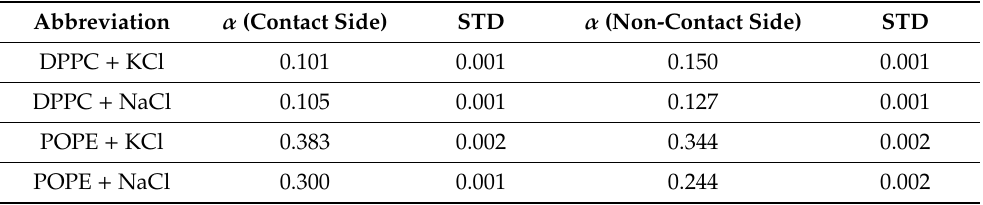
Table 1. α parameters based on the fitting function presented in Equation (2). All results were obtained for the bilayers with the presence of the protein bound to